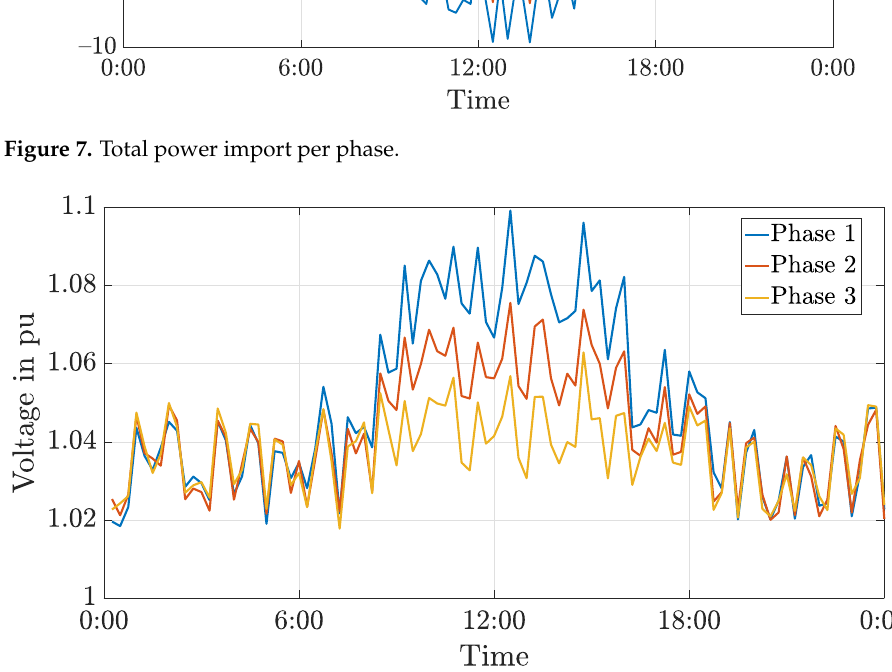
Figure 8. Voltages at the end of the